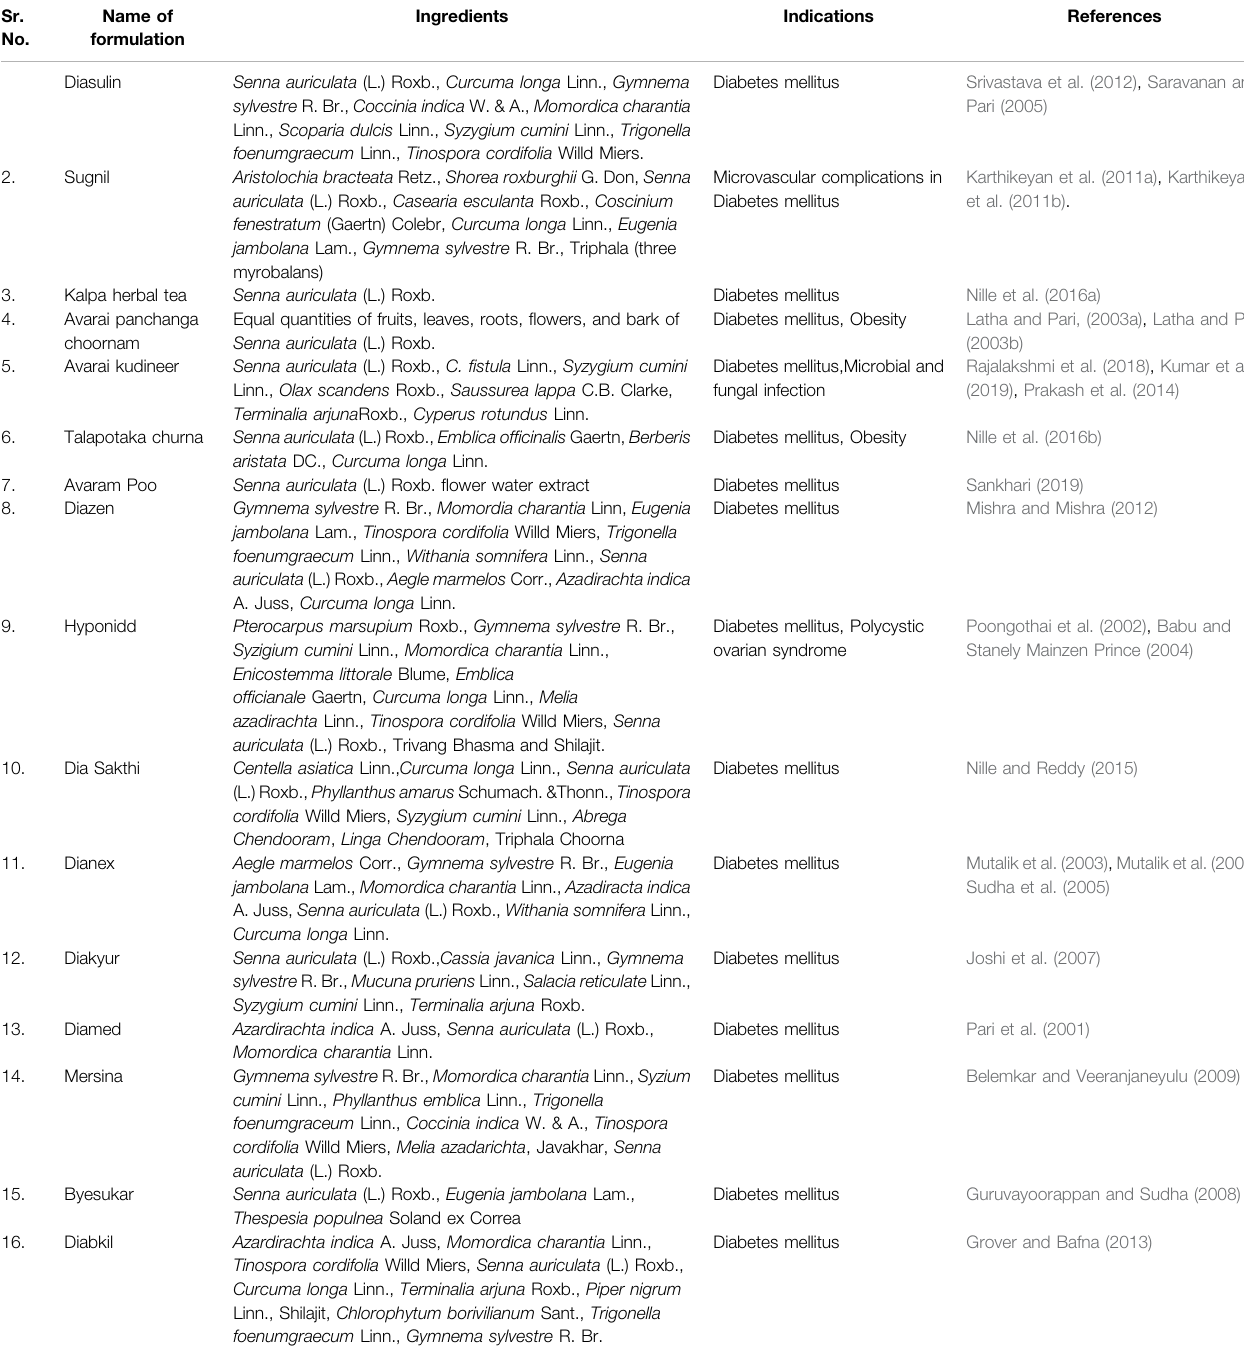
TABLE 2 | List of formulations in which Senna auriculata (L.) Roxb. is used as principal ingredient. Sr.